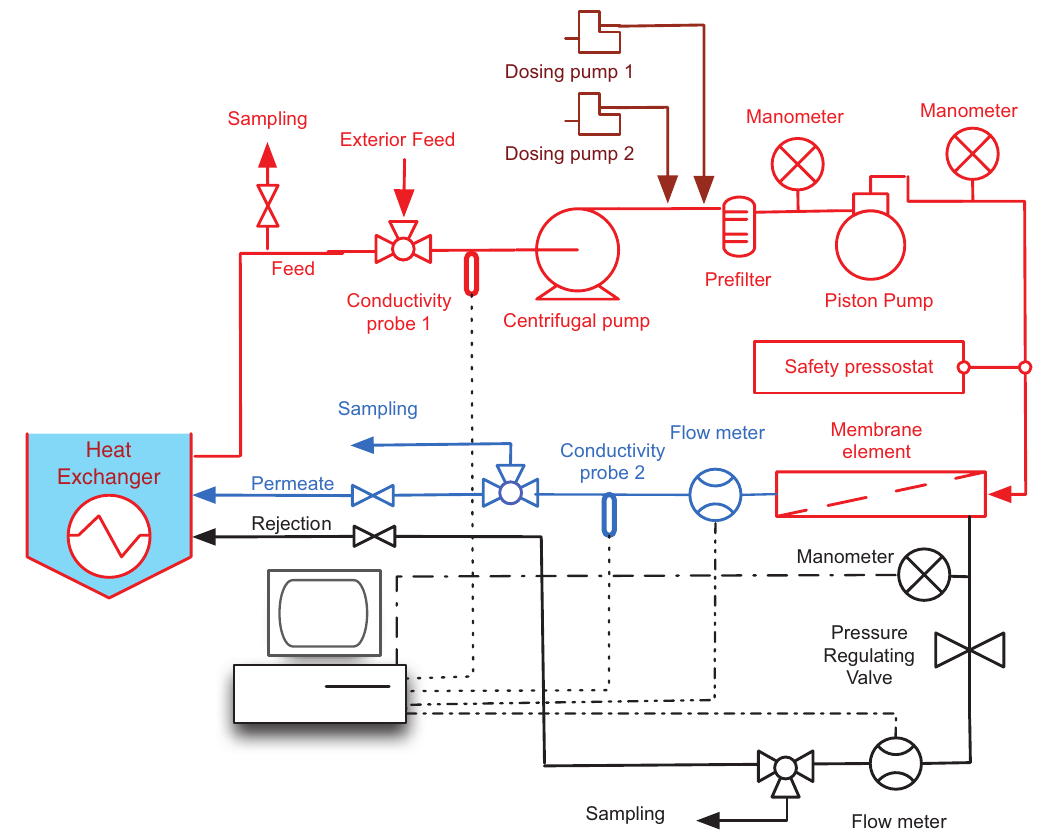
Fig. 1 – Spiral-wound desalination